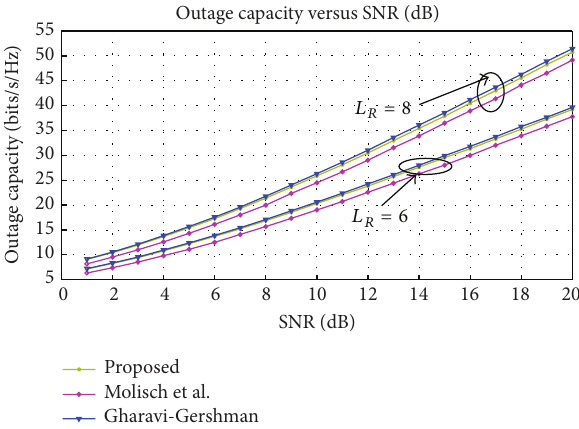
Figure 6: Plots showing the variation of outage capacity versus SNR in dB for 𝑀 𝑇 = 16 , 𝑀 𝑅 = 16 , and 𝐿 𝑅 = 6 and 8 under i.i.d. channel condition.